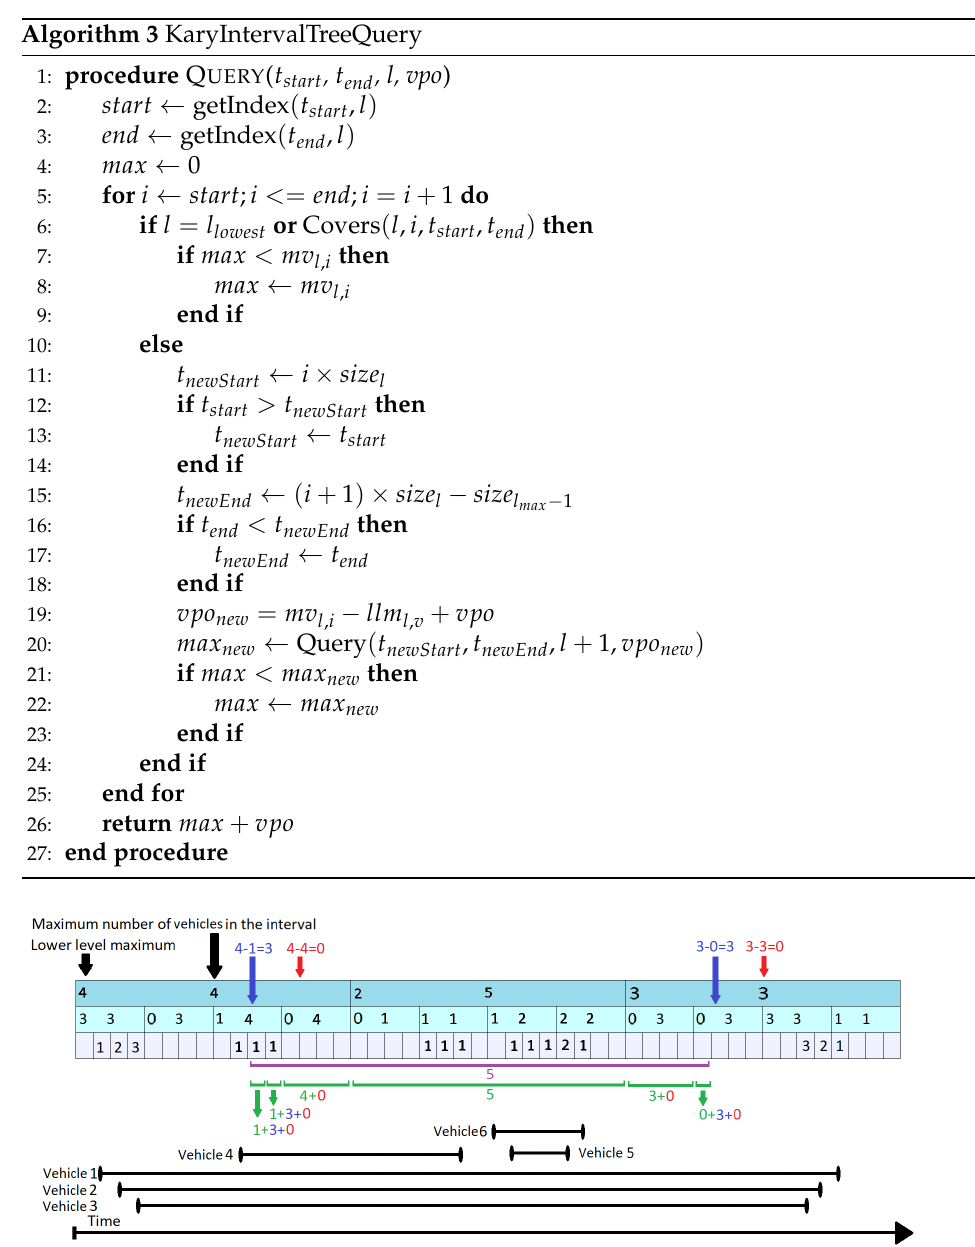
Figure 6. KI Tree Query on Time Interval Starting at Second 11 and Ending at Second 37 . The KI Tree Query algorithm runs in a top-down approach starting at topmost level (level 1) and iterating through all the elements that intersect the input interval in at least one point. For the given example, it checks all the three positions at the first level. Since the interval represented at position 1 (first cell in the indexed array from level 1) does not overlap completely over the purple area, it goes to the lower layers until it encounters an interval completely contained in the input. As it descends, it adds up all the passing over vehicles from the superior layers. In Figure 6 it can be seen that the number of vehicles passing over for levels 1 (marked with red) and 2 (marked with blue) are added to the values found at the lowest layer. At time t = 13 the query is back at level 2. It does not need to look at a lower level, as mv 2,4 overlaps completely the input time interval. Starting with t = 17, the topmost level (level 1) can answer for the next time interval that starts at second 17 and ends at second 32. As we approach the end of the input interval, the query descends again to lower layer and as it goes along it maintains a maximum of all the values